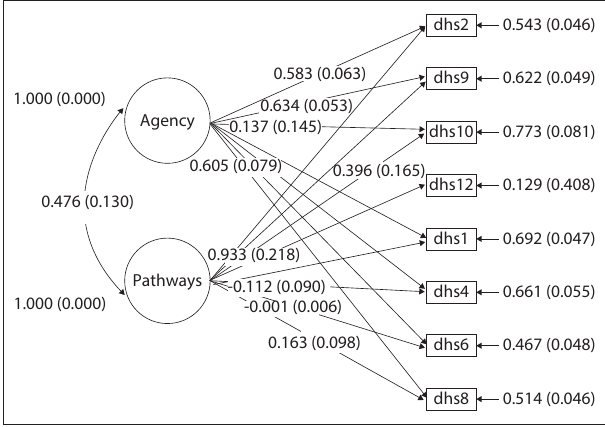
FIGURE 2 : The exploratory structural equation modelling two-factor solution for sample 1 ( n = 383).